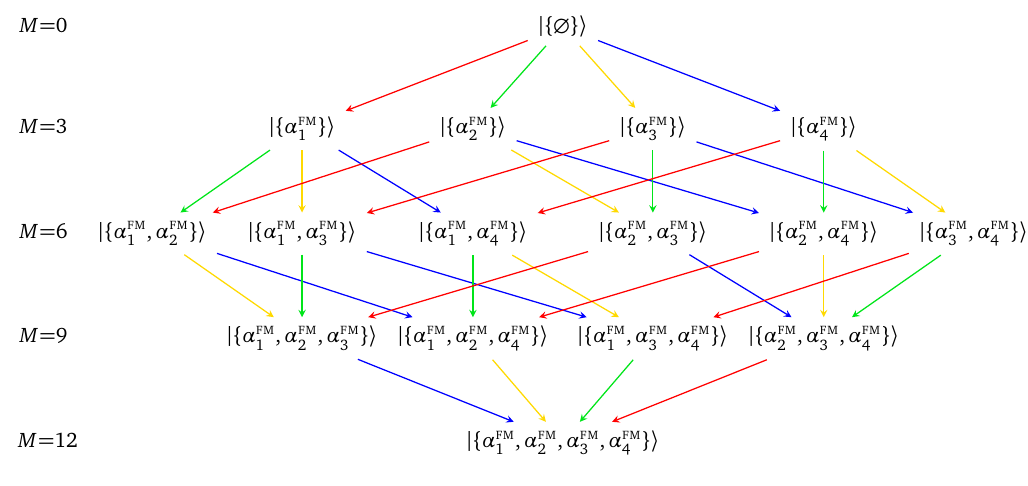
Figure 4: Illustration of a descendant tower from the pseudovacuum for N = 12, ∆ = 1 / 2, φ = 0. Arrows of different colours correspond to the addition of different FM